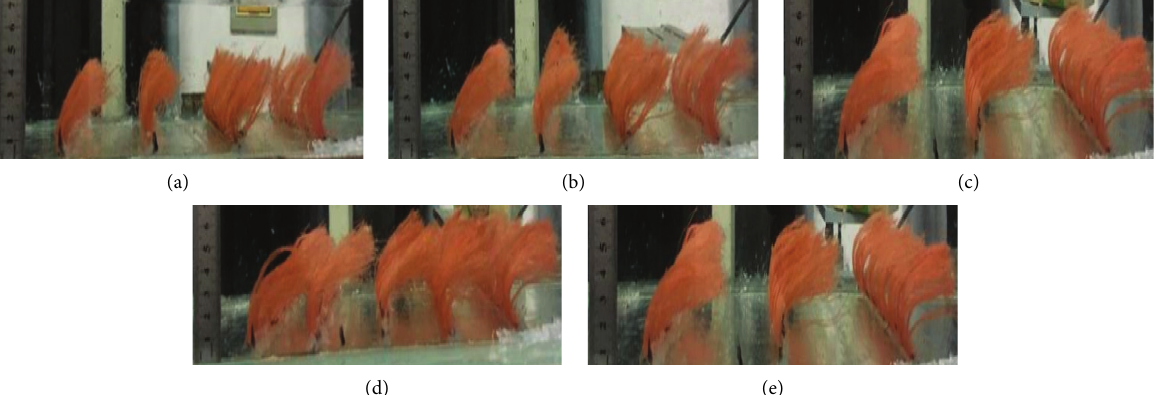
Figure 2: The lodging of bionic grass. (a) H25-1, (b) H25-1.2, (c) H25-1.5 (D252), (d) D251, and (e)